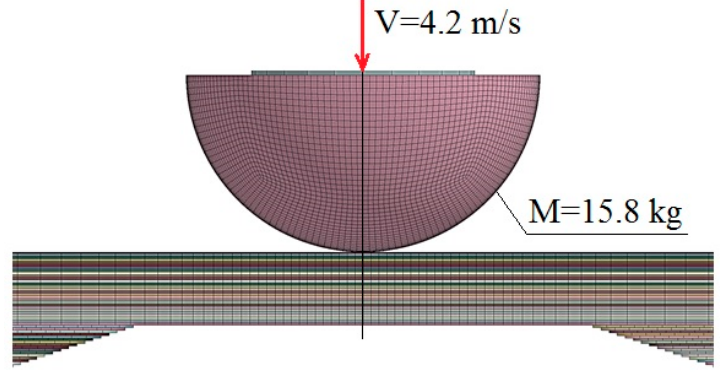
5 of 12 Figure 1. Stiffened panel with impact damage. a —panel length; b —half panel width or the distance between the stringers; h 1 —the composite plating thickness; b 1 , b 2 , h 2 —the stringer geometric parameters; h 3 —the sum of the stringer shelf thickness and the composite plating thickness; h —the sum of stringer height and the composite plating thickness; P —force caused by impactor.